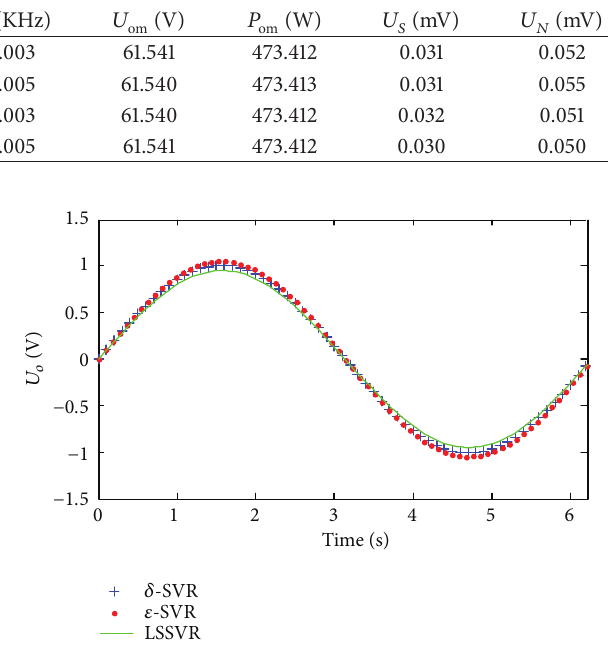
| with the three Figure 3: Local regression curve of output amplitude ( 𝑈 𝑜 ) with the u three